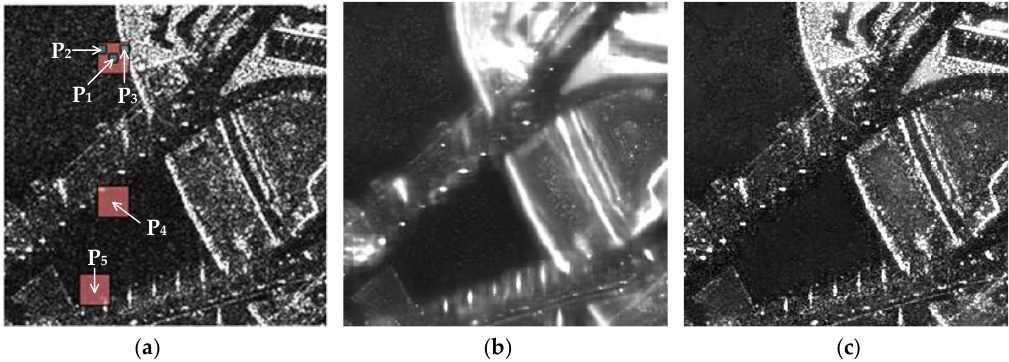
Figure 2. Processing results achieved using the conventional PPB algorithm: ( a ) the raw single look complex image, ( b ) the result processed using Equation (1), and ( c ) the result processed by Equations (1) and (5). ( a ) There are three search windows centered on P 1 , P 4 , and P 5 , and three patches centered at P 1 , P 2 , and P 3 .